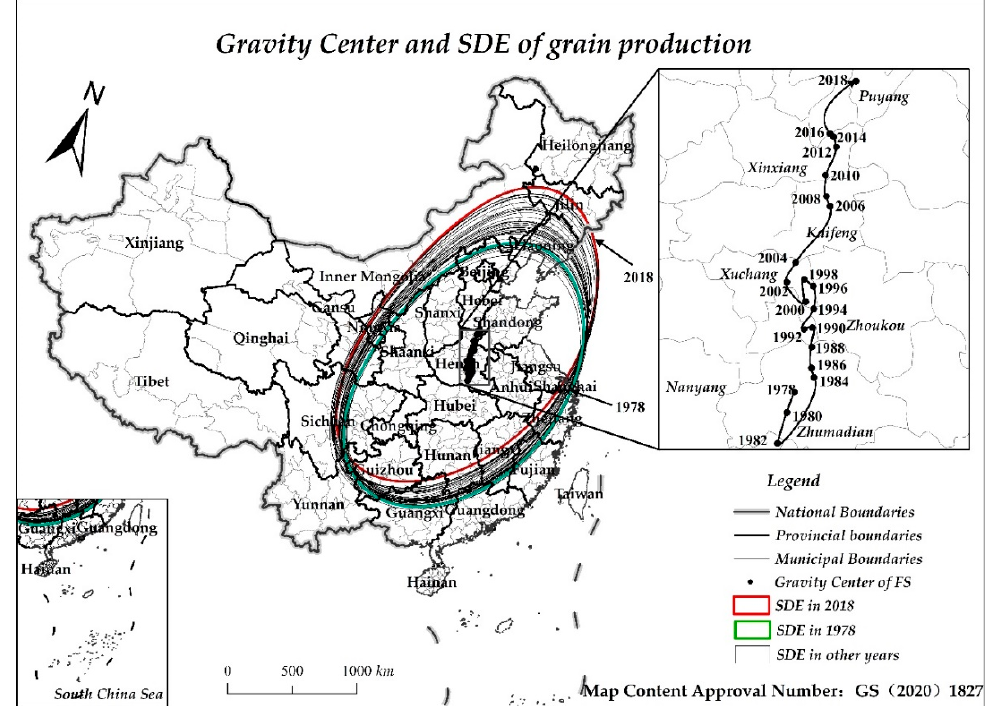
Figure 2. The gravity center (GC) and standard deviation ellipse (SDE) of grain production in China since 1978.